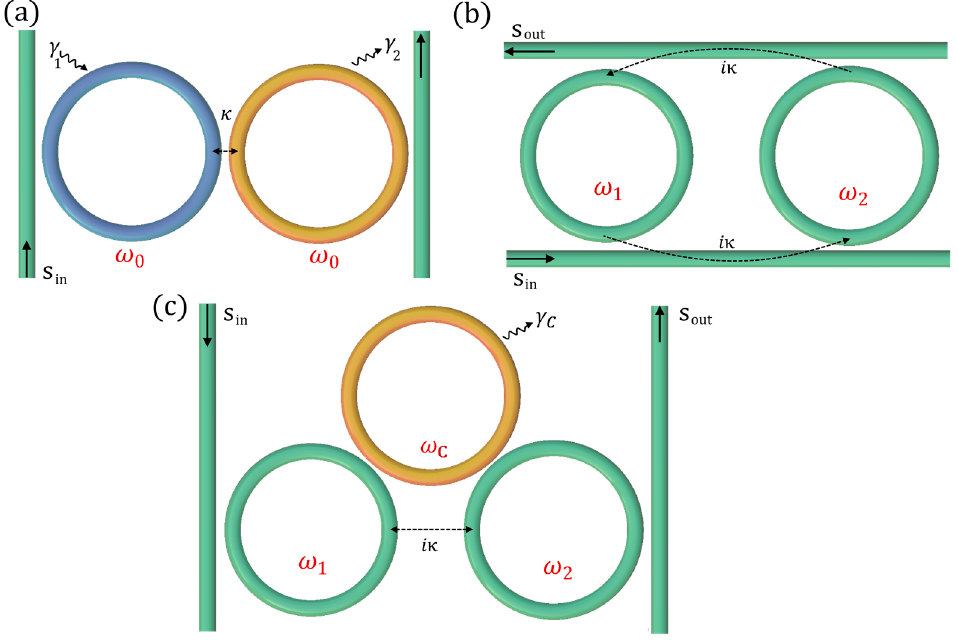
Figure 8. Coupled optical resonators realizing PT-symmetric ( a ) and anti-PT-symmetric ( b , c ) Hamiltonians.